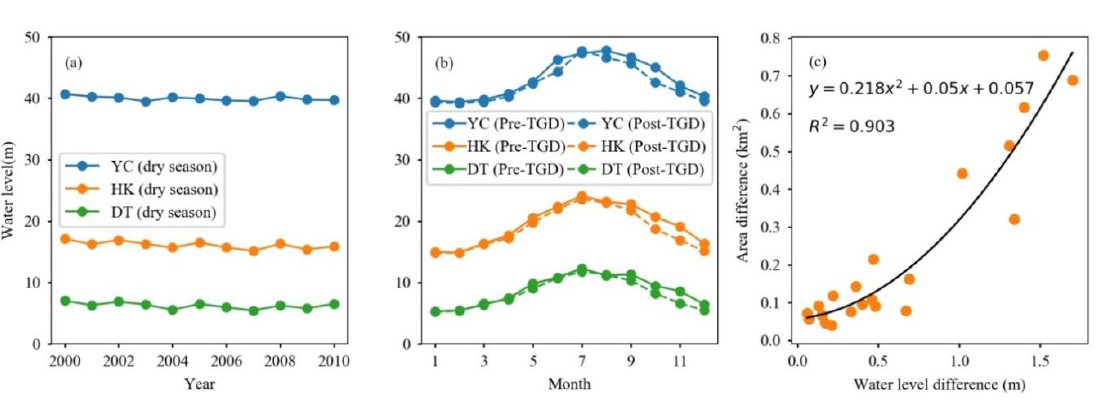
Figure 2. Water level variations at the three gauging stations (YC, HK, and DT as shown in Figure 1) from 2000 to 2010: ( a ) annual variations of monthly-averaged water levels in dry season (i.e., November to March) and ( b ) seasonal variations of annual-averaged water levels over pre-TGD (2000-2002) and post-TGD (2003–2010) periods. ( c ) The sensitivity of MCB area changes to water level fluctuation.